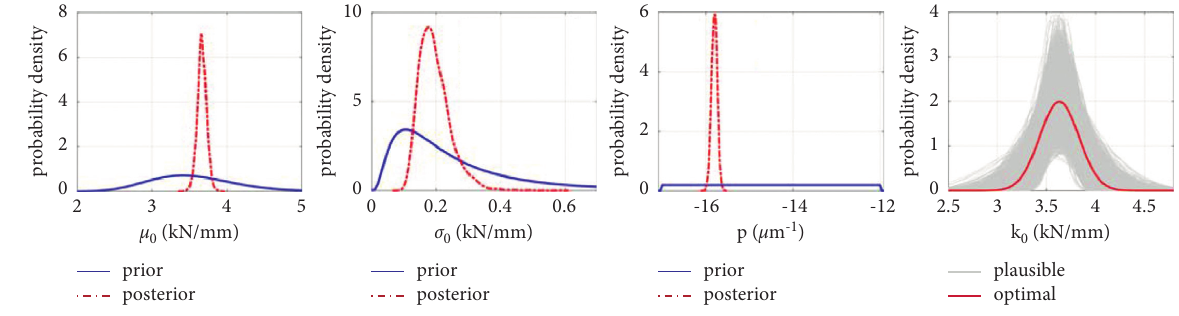
Figure 19: Identification results of PDFs for model parameters. Table 5: Identification results for the engineering example. Parameter